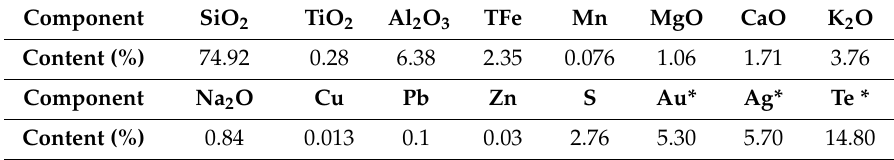
Table 2. Percentage concentrations of multi-element minerals.